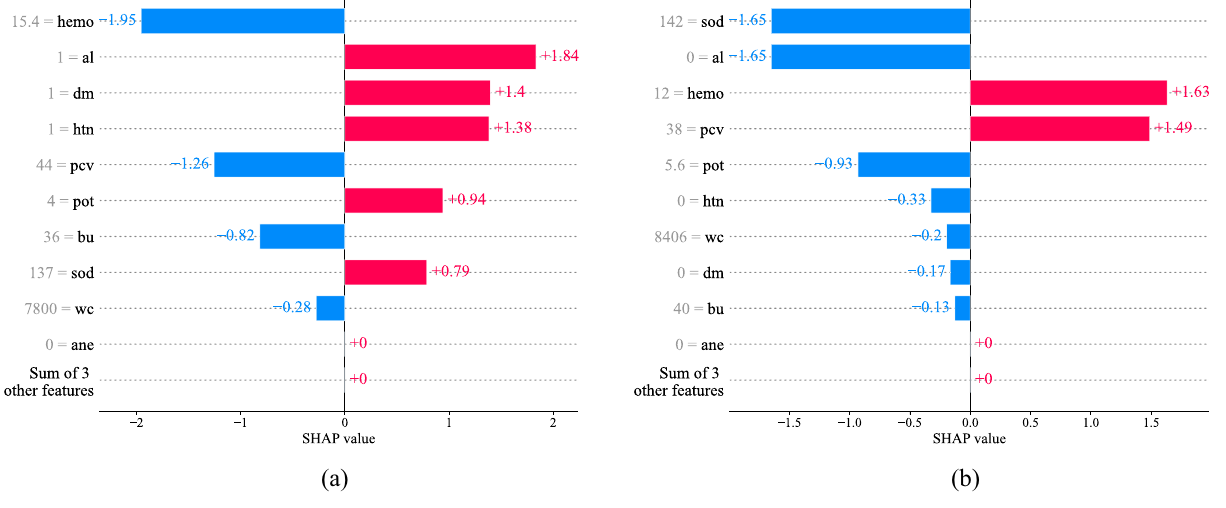
Figure 8. SHAP analysis of a single sample from Set 4. ( a ) Correctly classified (ID: 0, True: CKD, Predicted: CKD). ( b ) Misclassified (ID: 140, True: CKD, Predicted: